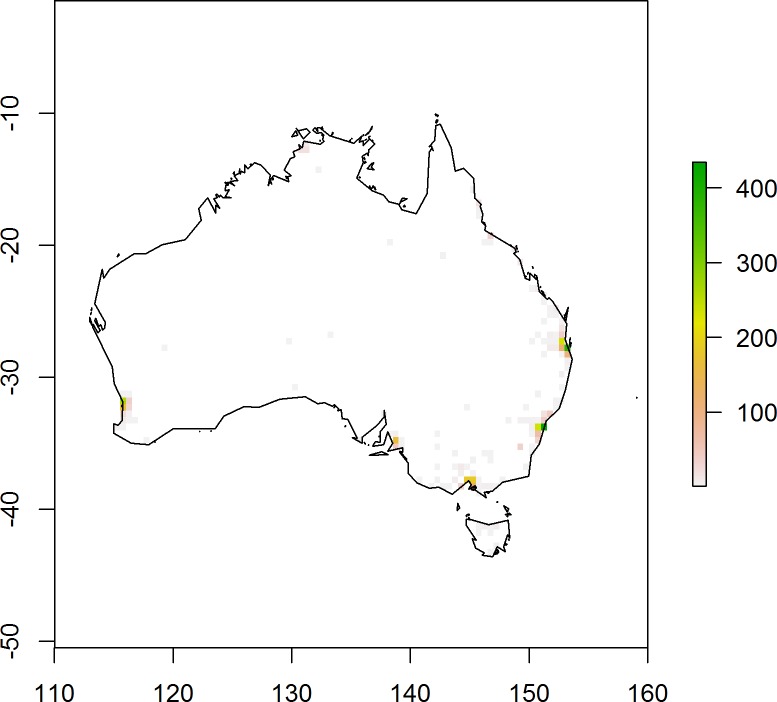
The distribution of bird escapes in Australia for the period 1999–2013.Presented as the number of missing bird reports per 60x60 km cell resolution. The Brisbane region accounted for 31.4% of all incursion events, followed by Sydney (29.9%) and Melbourne (16.1%).